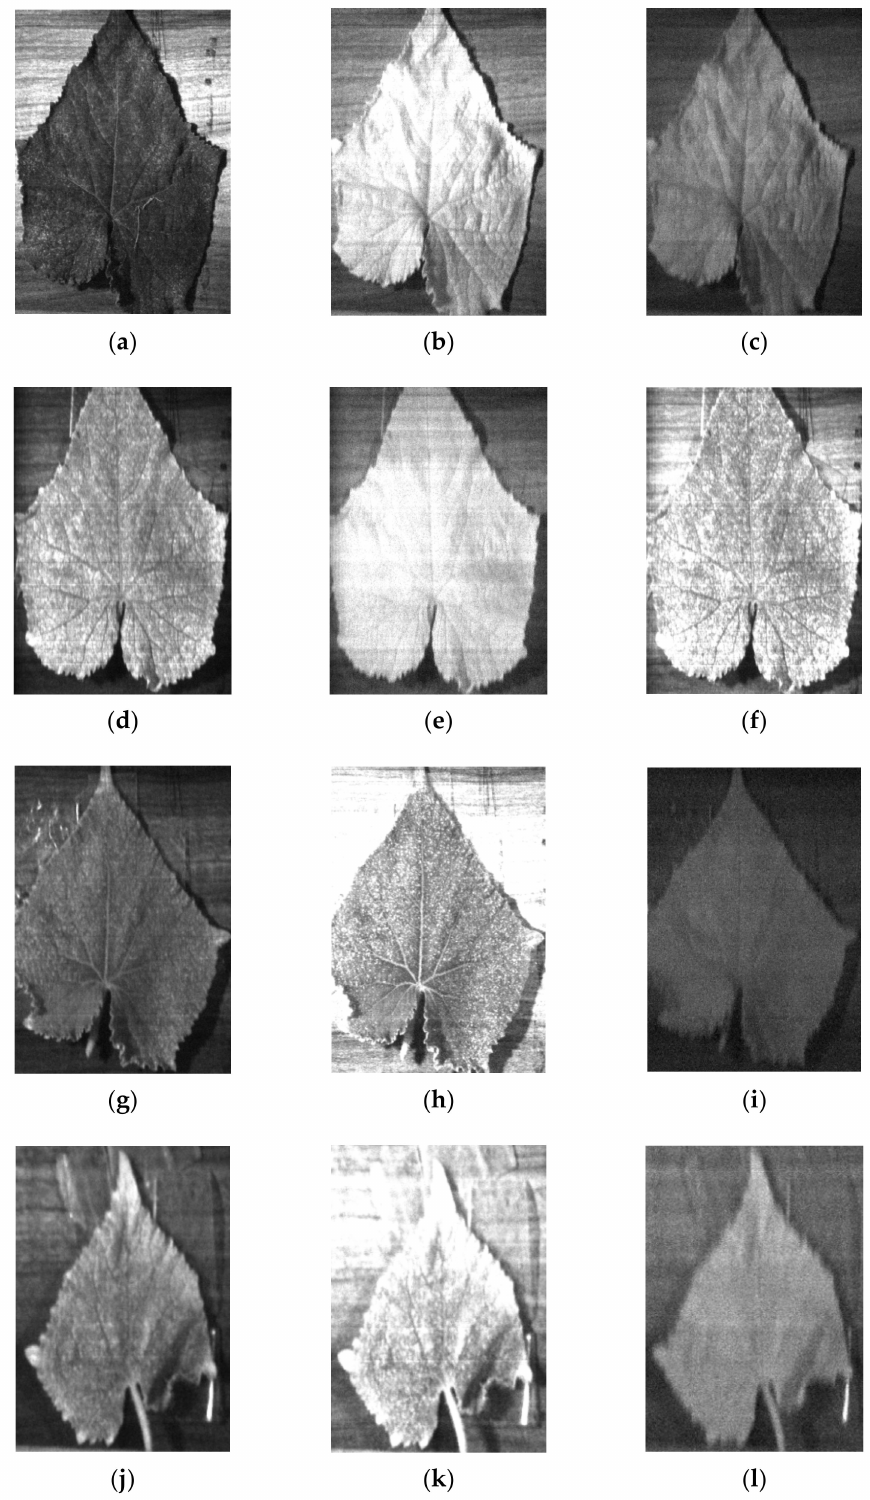
Figure 7. Hyperspectral images of the selected wavelengths during the sampling days. Left column ( a , d , g , j ): 715 nm; middle column ( b , e , h , k ): 783 nm; right column ( c , f , i , l ): 821 nm. Rows: days since the excess nitrogen started, from top to bottom: D0 ( a – c ), D1 ( d – f ), D2 ( g – i ) and D3 ( j – l ),